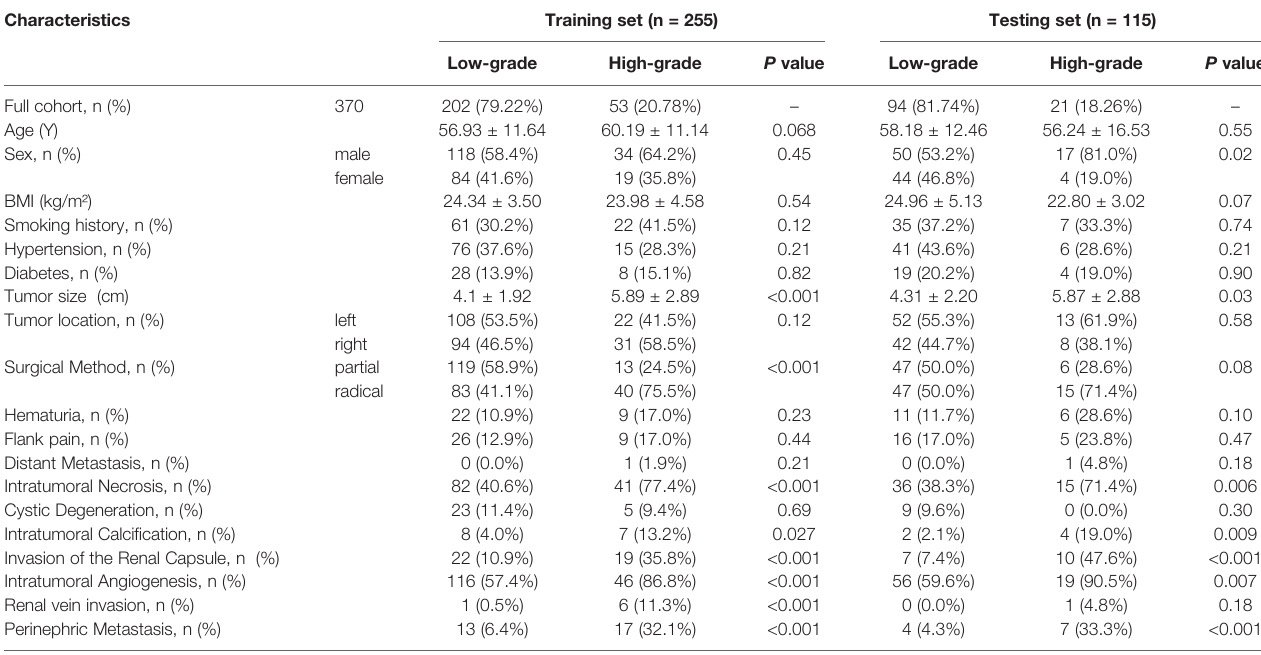
TABLE 1 | Clinic-radiological characteristics of CCRCC patients in the training and testing sets.